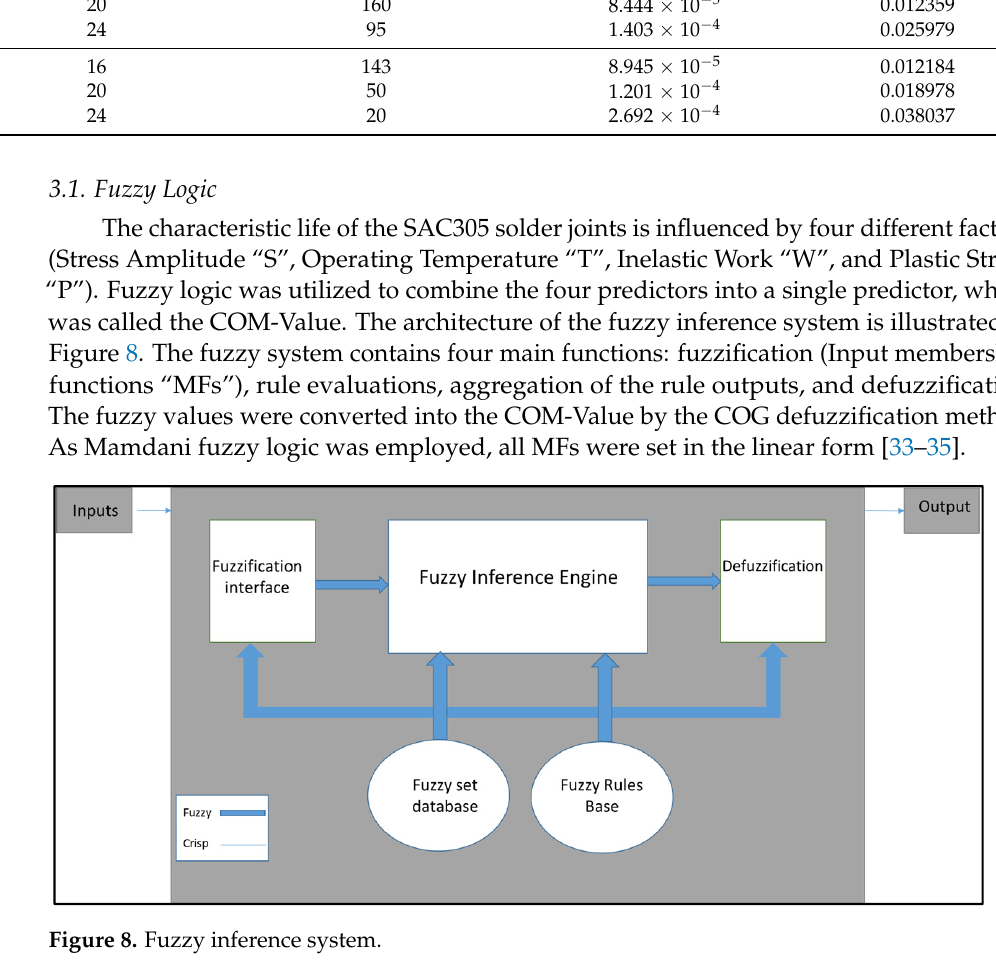
( d ) Figure 9. Inputs MFs for ( a )-operating temperature, ( b ) stress level, ( c ) inelastic work, ( d ) plastic strain).